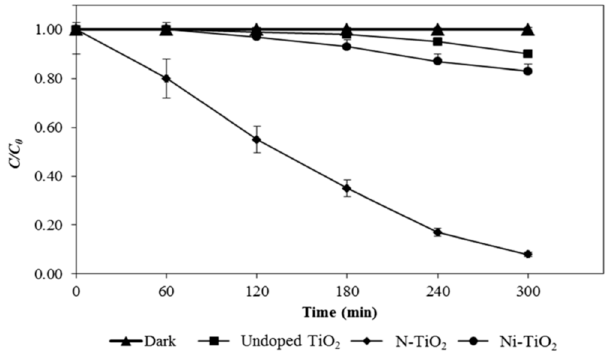
Figure 22. Survival ratio (C/Co) of S. aureus with neat TiO 2 , N-doped TiO 2 NPs and Ni-doped TiO 2 NPs under an 18 W visible light irradiation for different time periods. S. aureus without TiO 2 in the dark is used as a control. Statistically significant at p < 0.05. Reproduced with permission from [161]. Copyright Springer, 2016.